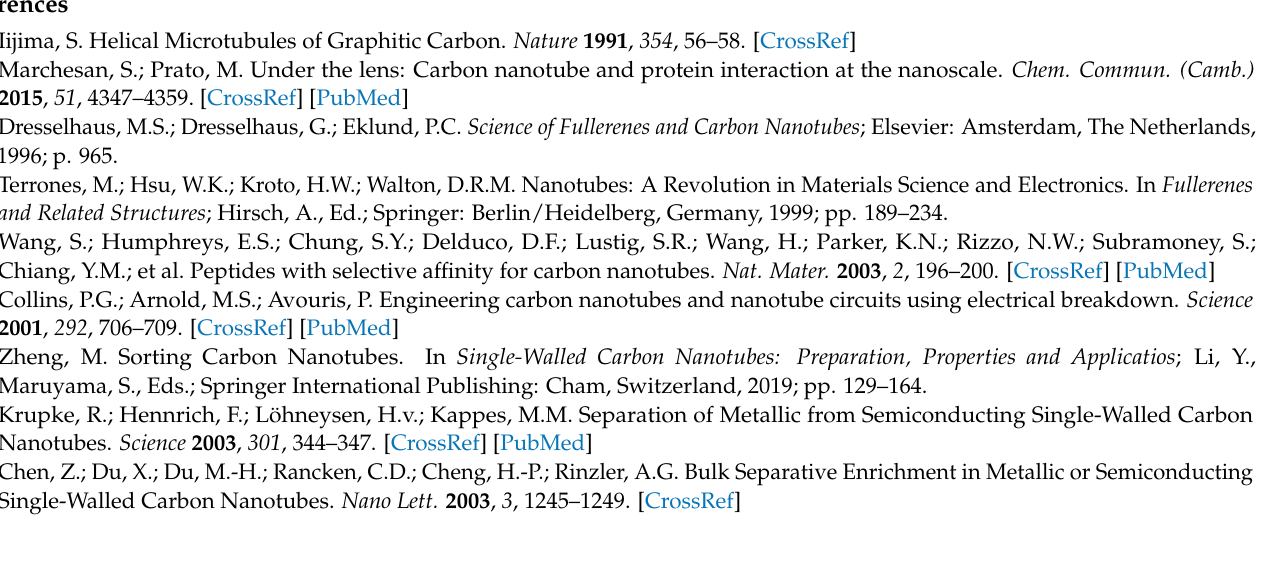
TGK; Table S1: Physical properties of tripeptides used in this study and their codes based on the international nucleotide sequence database; Table S2: Physical properties of each amino acid, which form the flanking residue of glycine in the tripeptide library. Glycine observed to be neither polar nor hydrophobic with its functional sidechain being a hydrogen atom exhibits achiral